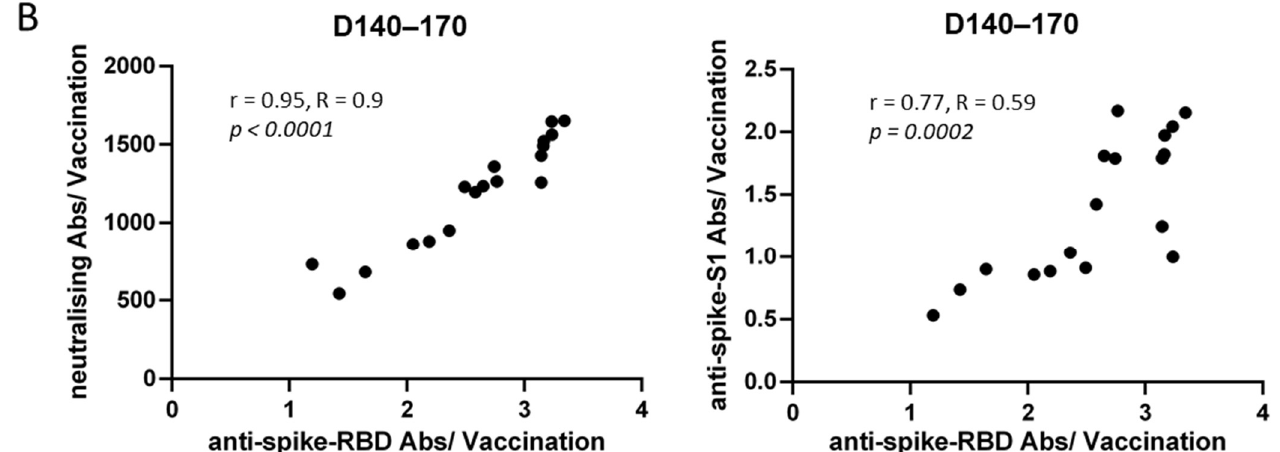
Figure 4. Correlation of anti-RBD antibody titers with NAbs and anti-S1 antibody titers in ( A ) SARS- CoV-2 recovered and ( B ) vaccinated individuals, on D120–160 and D140–170, respectively. Each dot represents a specific serum sample.